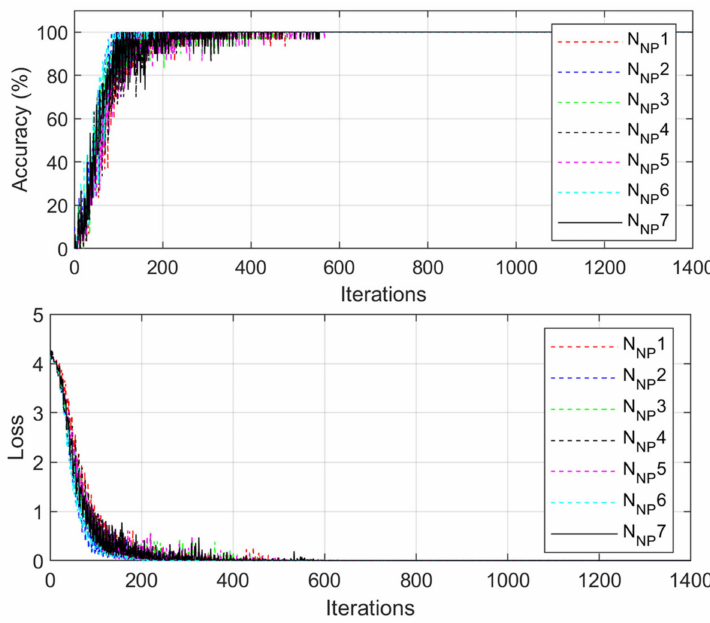
Figure A2. Training process and detection results. N NP #: network number.